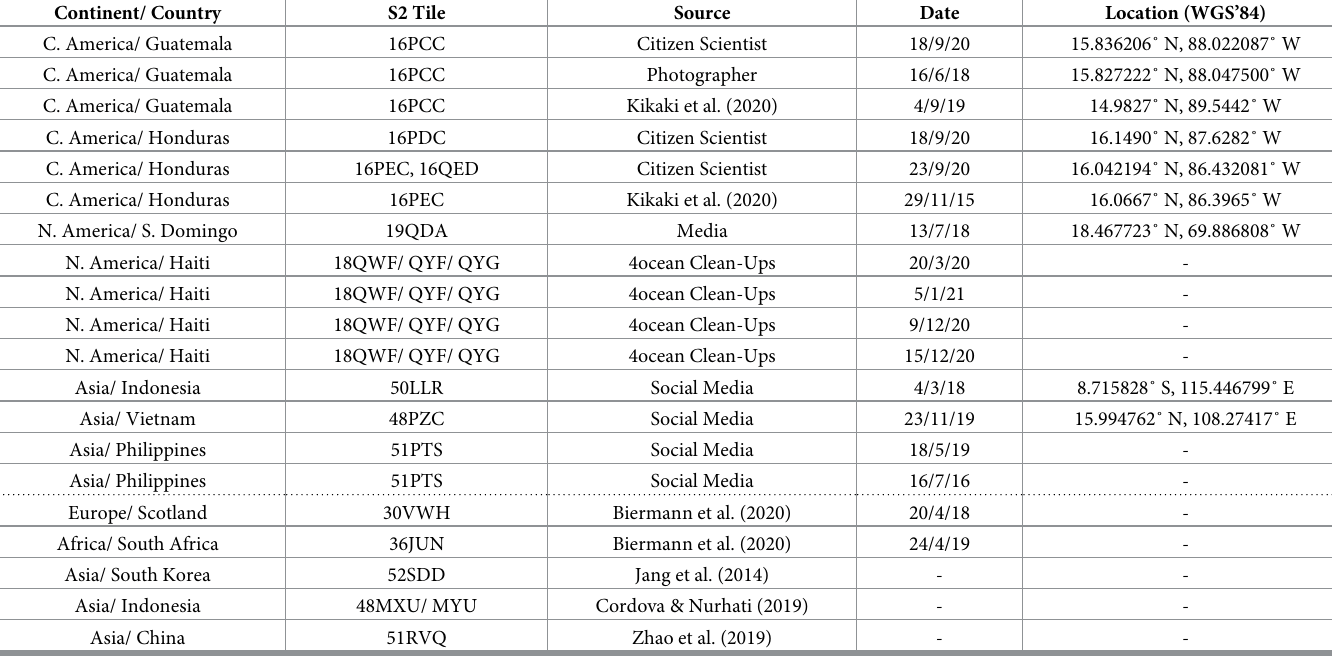
Table 1. Collected Marine Debris reports across different countries and continents for the period 2015–2021. The table shows the regions along with the reported events information (source, date and exact location). Continent/ Country S2